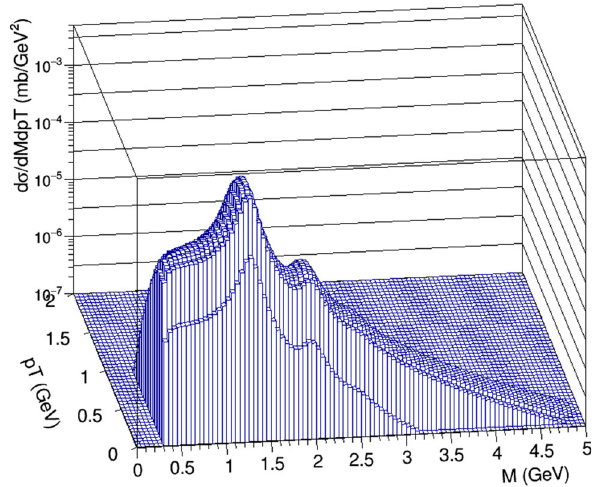
Fig. 10 Double differential meson cross section for contribution of f 2 trajectory